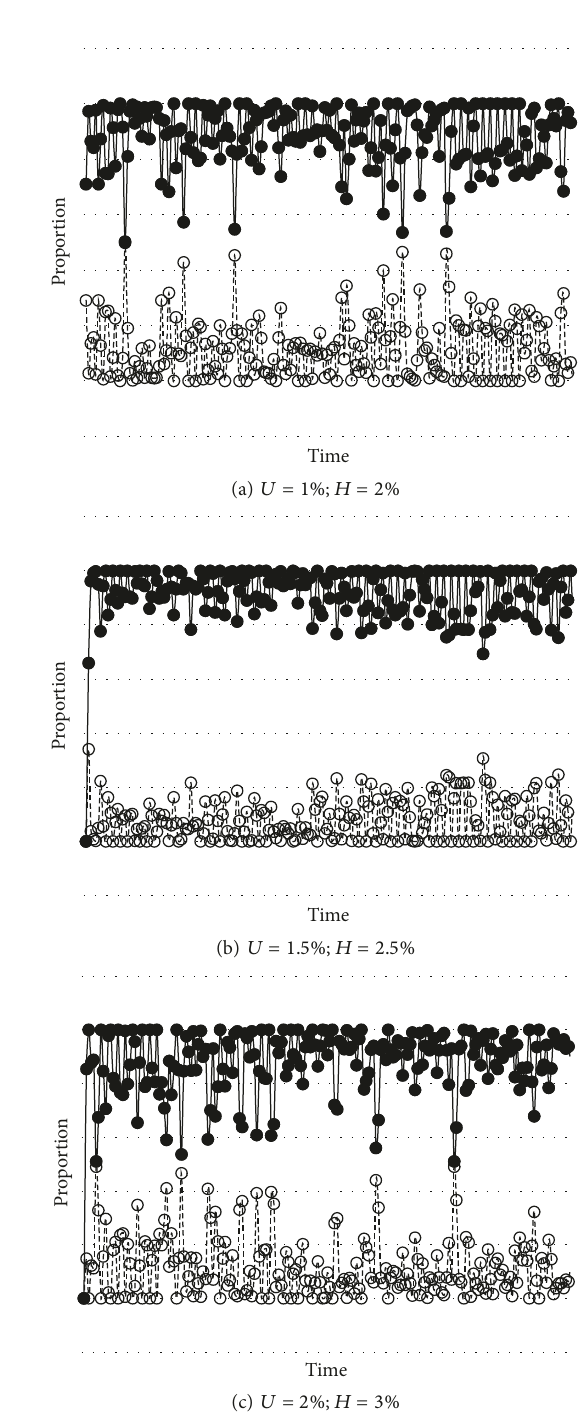
Figure 6: The evolutionary trend of the consumers’ strategy selec- tion in model